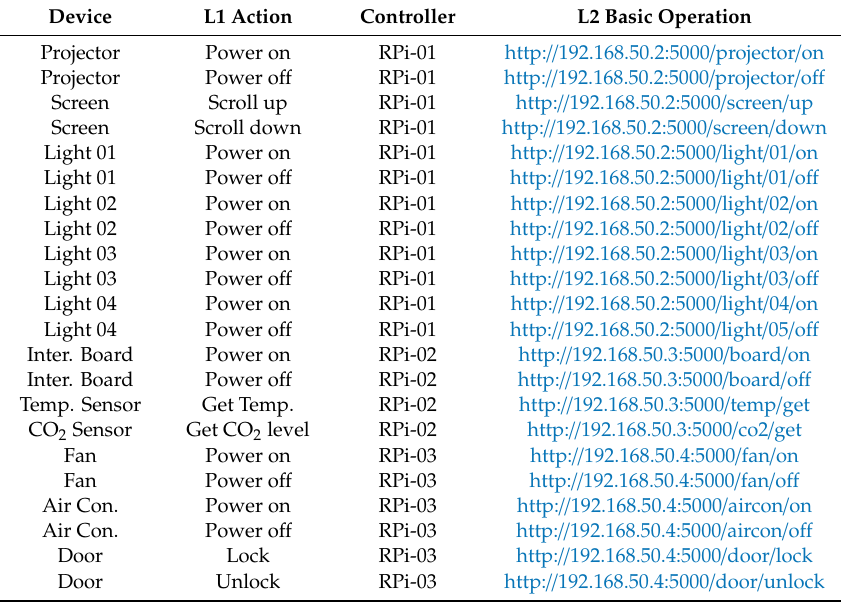
Table A2. Mappings of layer 1 device actions to the corresponding layer 2 basic operations.